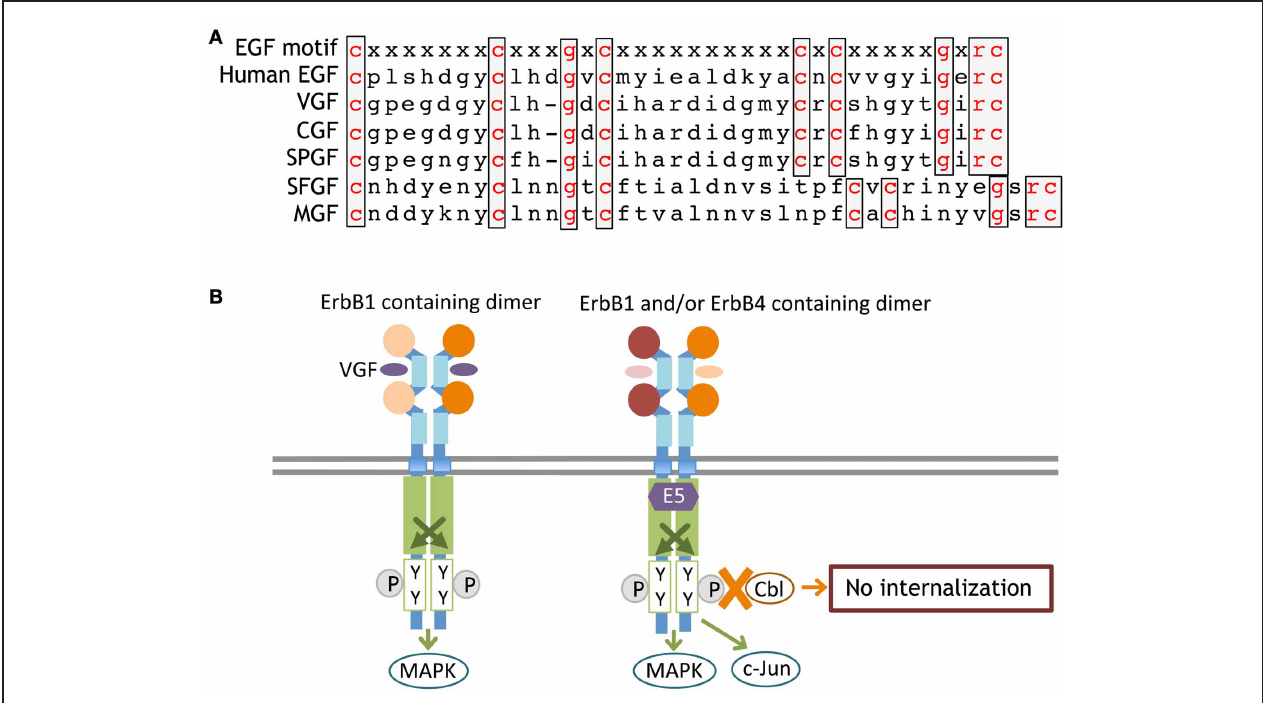
FIGURE 6 | Primary sequences of ErbB-interacting virokines and receptor interactions. The primary amino acid sequences of EGF and virokines in the poxvirus family are shown (A) . An ErbB